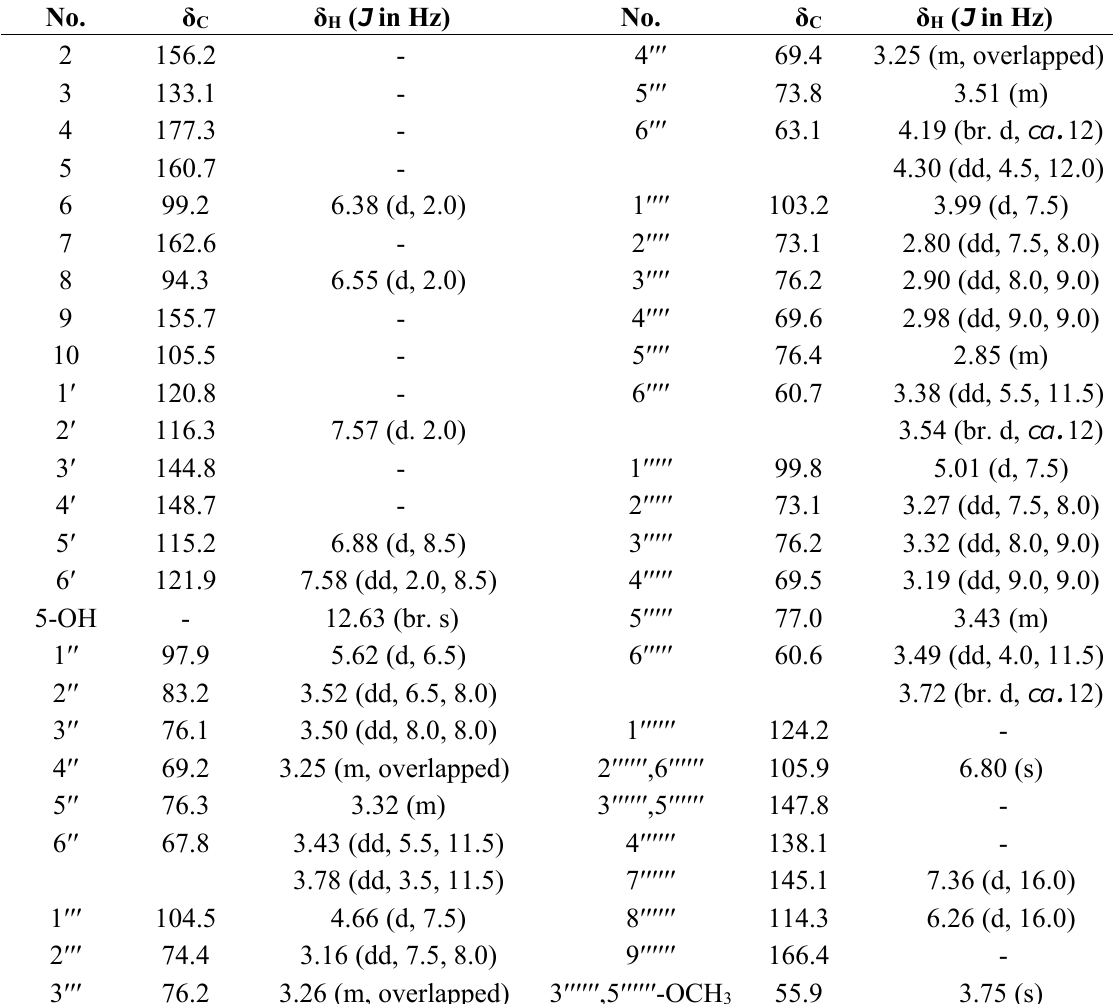
Table 5. 1 H and 13 C-NMR data for 5 in DMSO- d 6 (500 MHz for 1 H and 125 MHz for 13